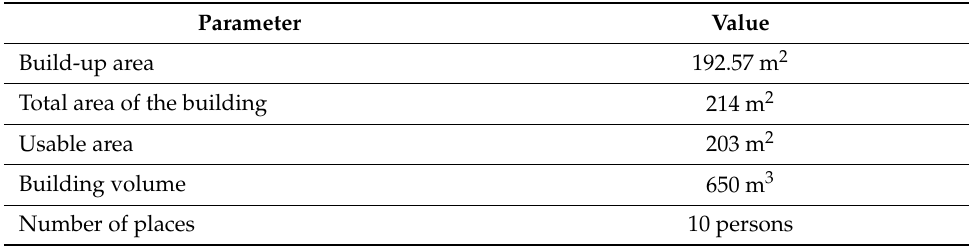
Table 6. Technical and economic indicators of the building.